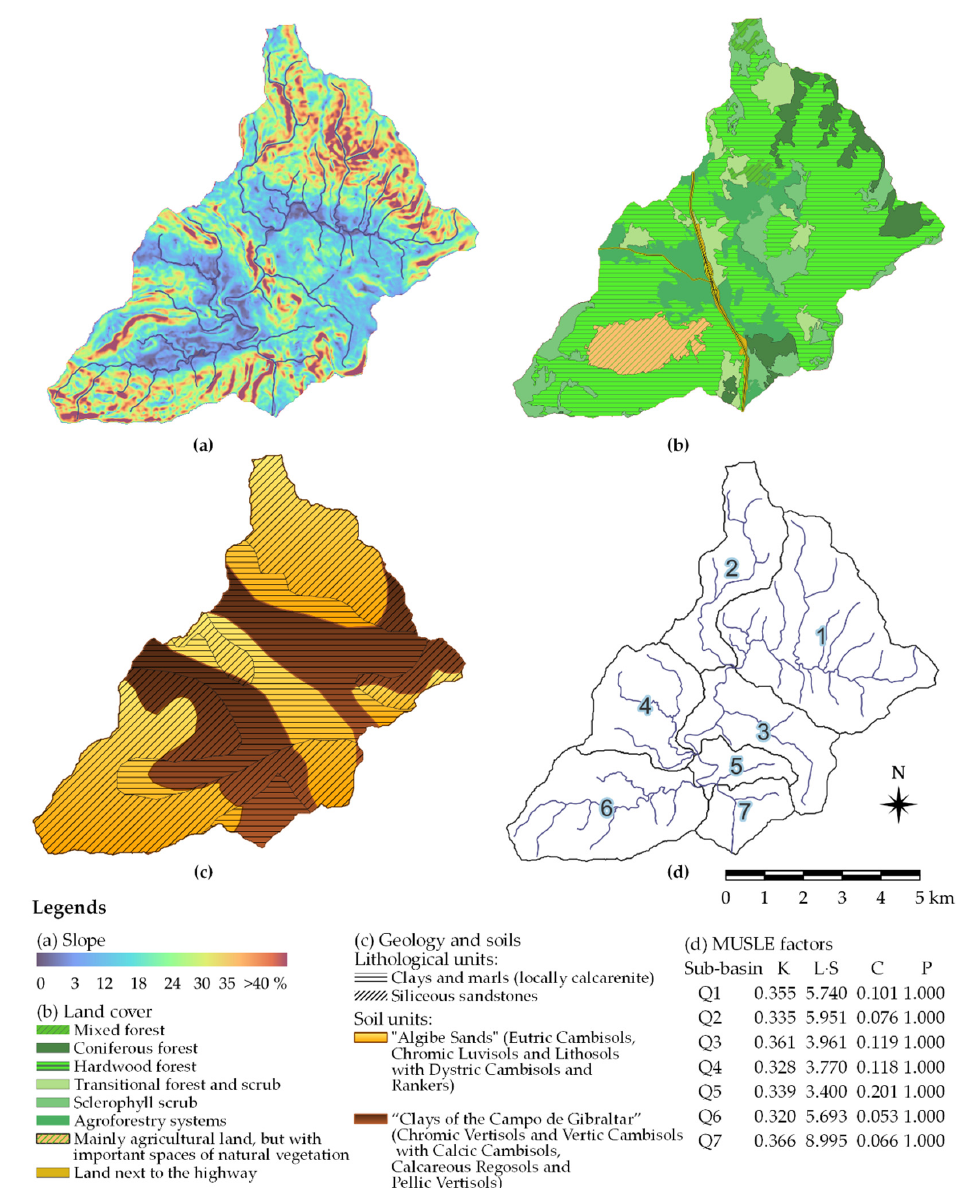
Figure 3. Thematic maps: ( a ) slope map, ( b ) land-cover map, ( c ) geological and soil map; ( d ) MUSLE